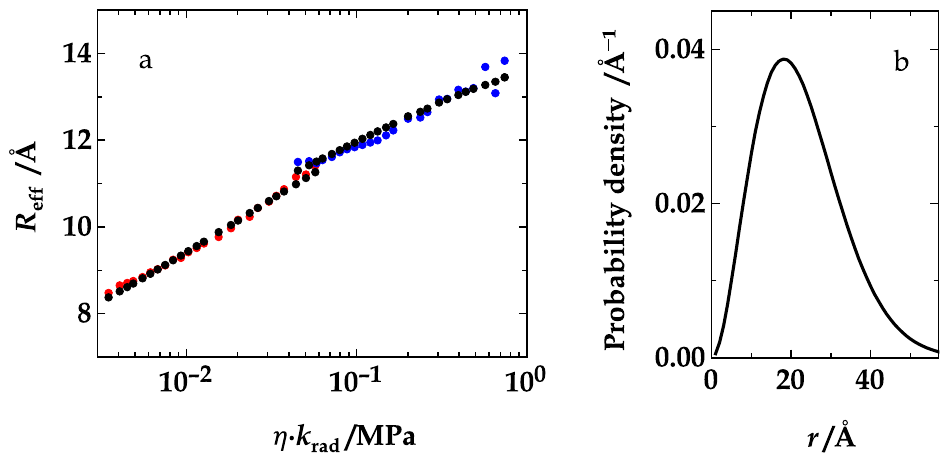
Figure 7. ( a ) The effective donor/acceptor distance in NAla-(GS) 6 -Dbo-NH 2 (red) and 5-F-Trp-(GS) 6 -Dbo-NH 2 (blue) plotted against the product, η k rad , as in the top panel of Figure 5. The black circles represent the best fit of the data points, as obtained from an optimization based on the numerical solution of the Haas-Steinberg equation (HSE, Equation (18)). It yielded a diffusion coefficient of 55.4 Å 2 /ns in the absence of ethylene glycol, and a skewed Gaussian distance distribution, p ( r ) = cr 2 · exp( − a ( r − b ) 2 , with a = 1.27 × 10 − 3 Å − 2 and b = − 25.3 Å, as shown in ( b ) for all employed ethylene glycol concentrations (0–92%). The normalization constant, c , is fixed by the condition that ∫ p ( r ) dr = 1.